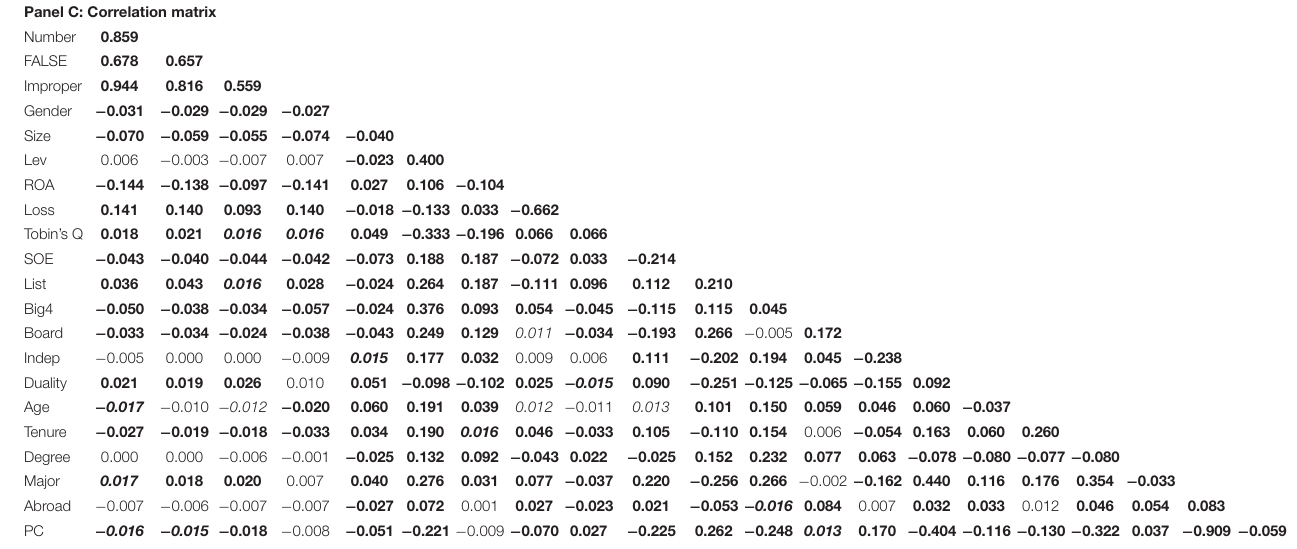
Panel C: Correlation matrix Number